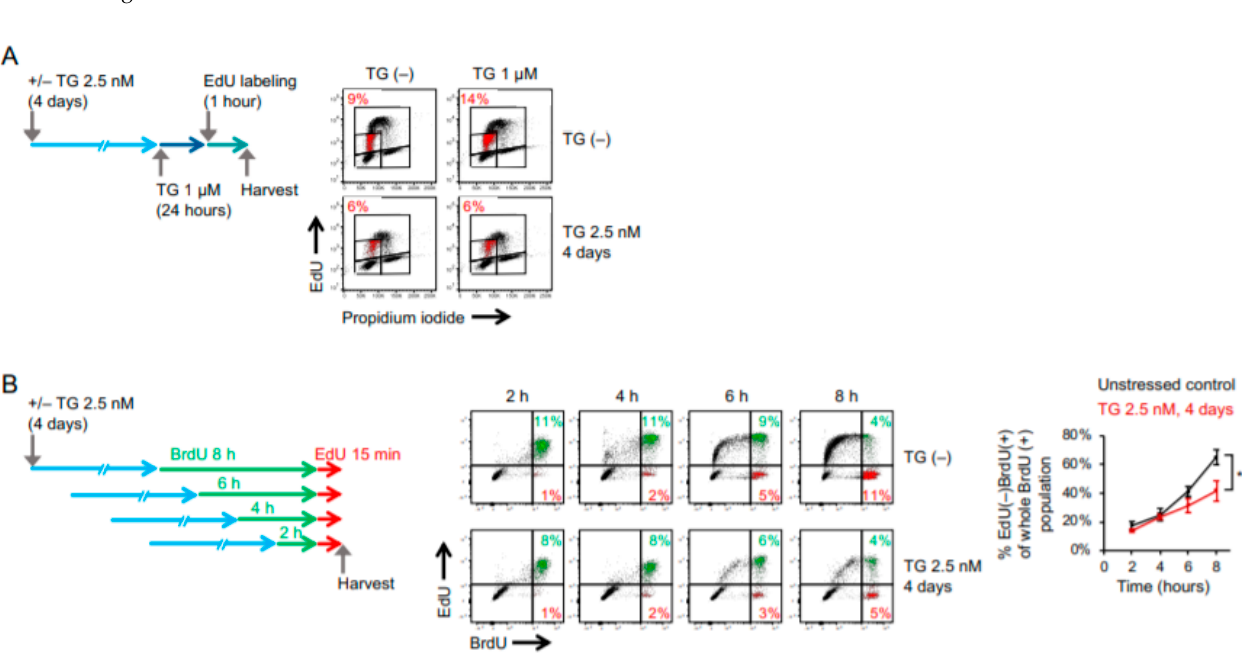
Figure 1. Adaptation to persistent endoplasmic reticulum (ER) stress is accompanied by phenotypic transition. ( A ) OECM1 cells were grown in culture media containing 2.5 nM of thapsigargin (TG) for 0 to 96 h, and time-dependent induction of ER stress response assessed by the levels of phospho-eIF2 α , eIF2 α , glucose-related protein 78 (GRP78), and C/EBP Homologous Protein (CHOP) were analyzed by Western blots. OECM1 cells treated with 1 µM of thapsigargin for 4 h were used as a positive control to show that ER stress signaling through CHOP in these cells is intact. ( B ) OECM1 cells grown in 1 or 2.5 nM of thapsigargin for 4 days were subsequently mock treated or treated with 1 µM of thapsigargin or 10 µg/mL of tunicamycin (TM) for 1 day, and the induction of ER stress response was analyzed by Western blots. ( C ) OECM1 cells were grown in culture media containing 0, 1, 2.5, or 5 nM of thapsigargin for 4 days, and their mesenchymal–epithelial transition was evaluated by Western blots examining the levels of E-cadherin and Vimentin. The α -tubulin and GAPDH were used as the loading control.